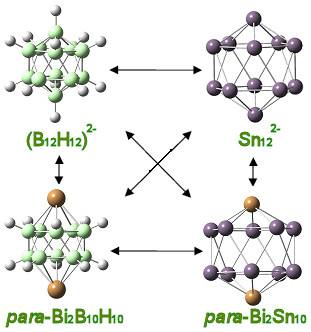
Schematic illustration of the CH → Bi/BH → Sn analogy. Correspondence of stannaspherene (Sn12)2- with (B12H12)2- and analogous bismuth functionalized structures.